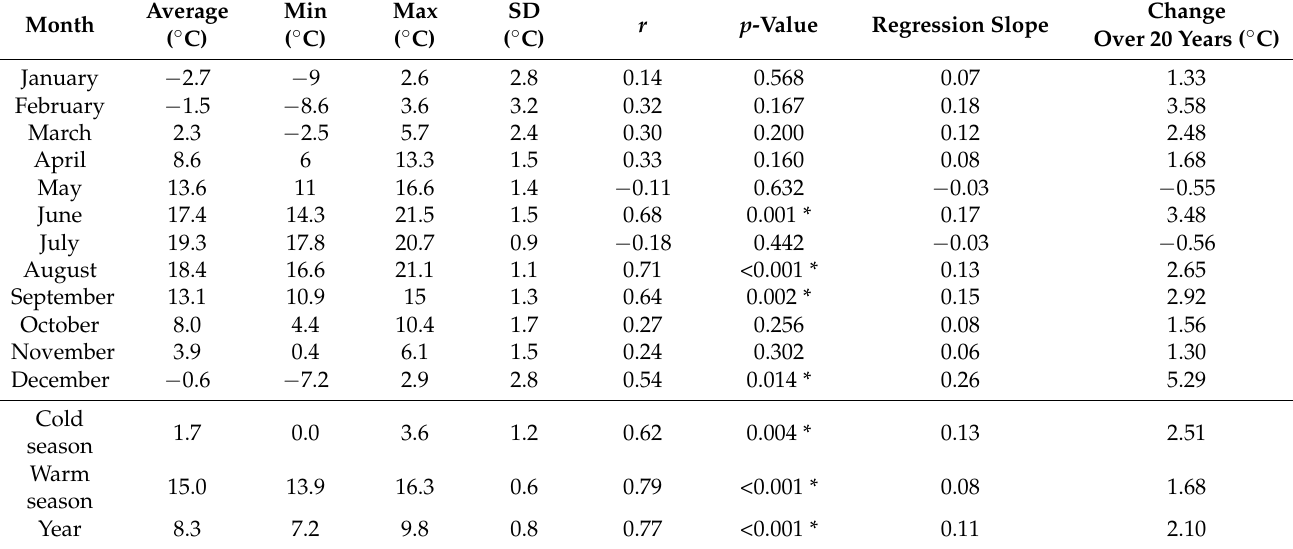
Table 2. Average air temperature trend for the years 2001–2020. Data compiled by the authors from the Reports of the “Roztocze” Base Station of the Integrated Monitoring of Natural